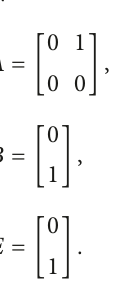
which indicates that the system matrices